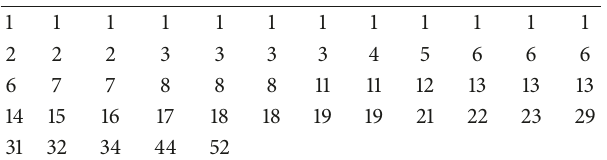
Table 8: Dataset related to the sugarcane harvester’s transmission